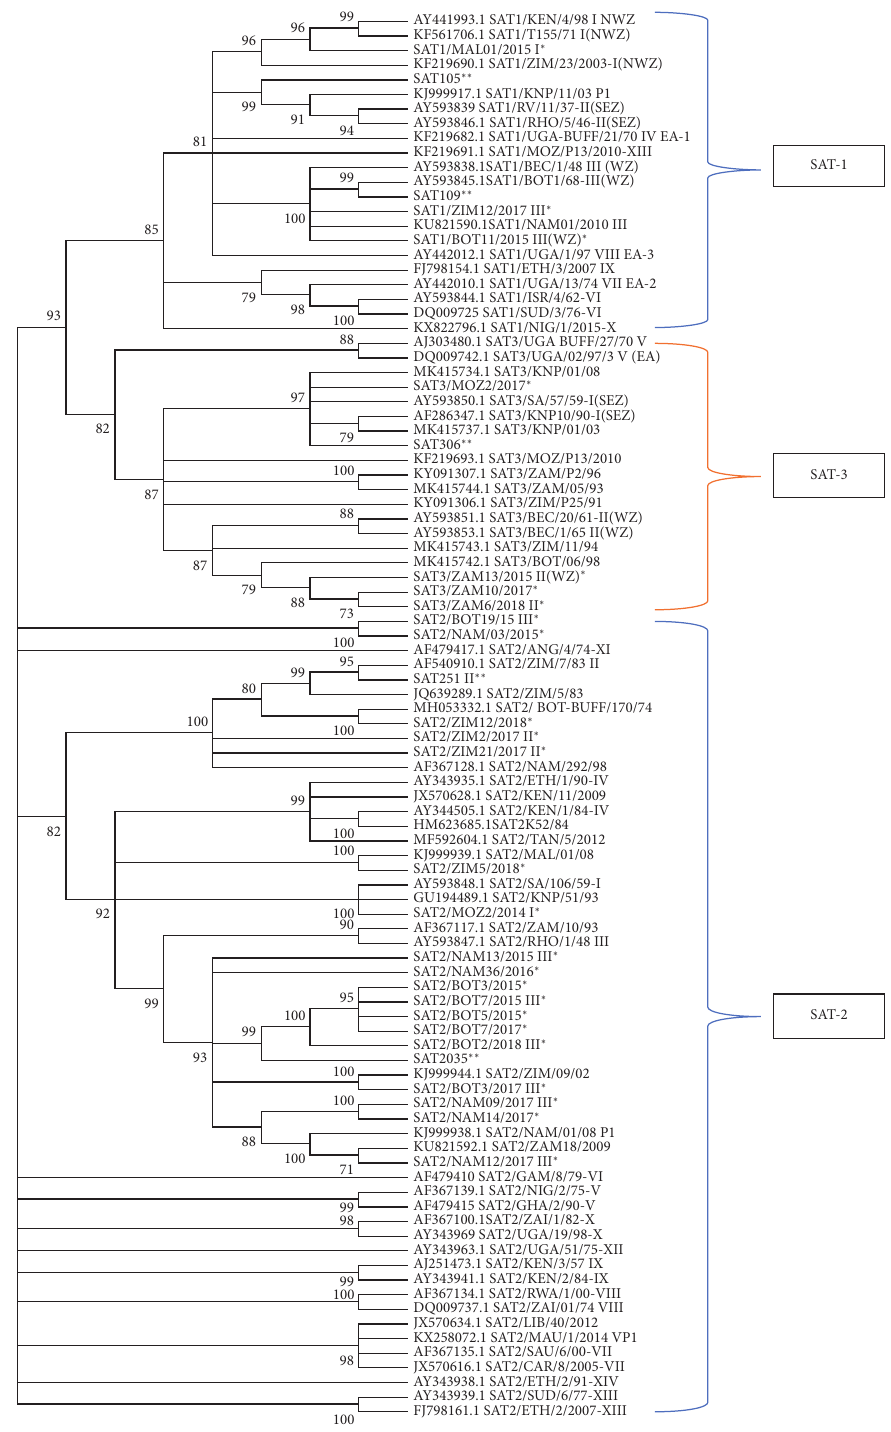
Figure 3: Evolutionary relationships of SATs strains and their topotypes. ∗ represents outbreak samples and ∗∗ are vaccine